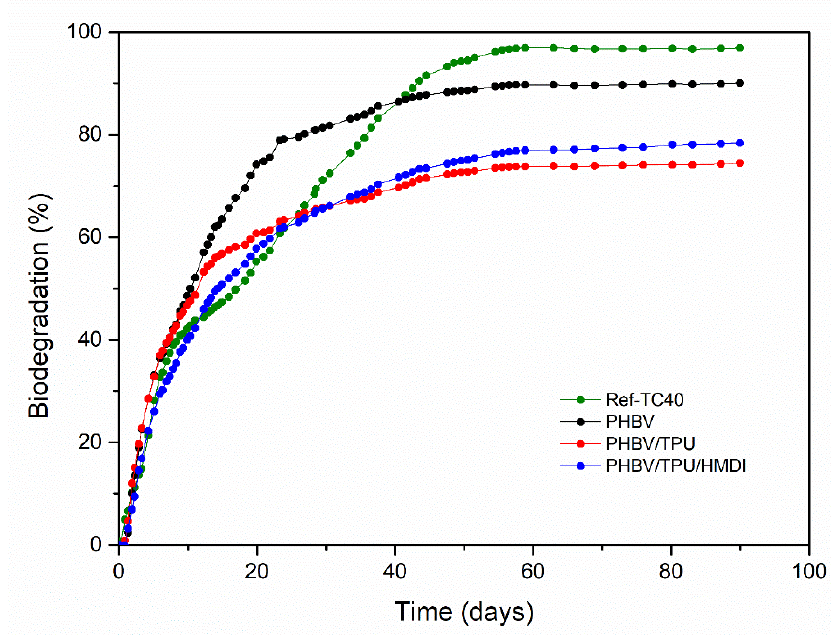
Figure 12. Biodegradation (%) in the composting conditions as a function of